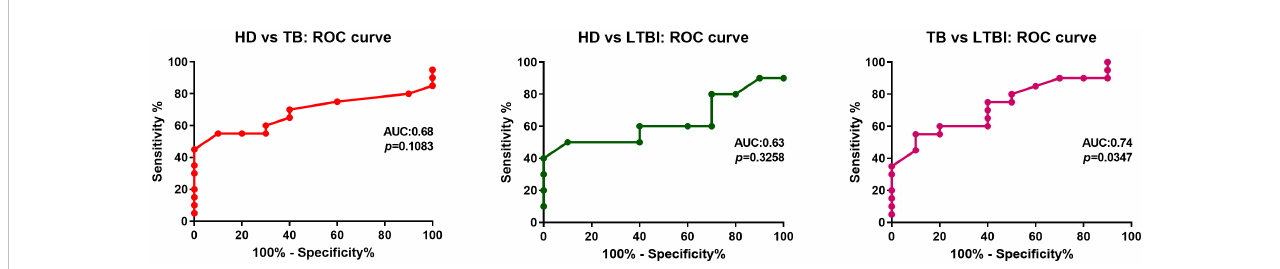
FIGURE 4 ROC curve analyses for evaluation of the predictive value of -53 CpG methylation on disease status. ROC curve analyses for evaluation of the predictive value of whole blood methylation levels at IFNG -53 CpG for differentiating HD individuals from TB, HD individual from LTBI and TB from LTBI. ROC, receiver operating characteristic; AUC, area under the ROC